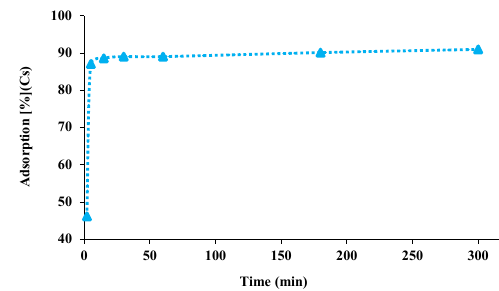
Fig. 6 The effect of contact time (10-300 min) on Cs(I) uptake, at 25°C and pH 7 with continuous shaking at 150